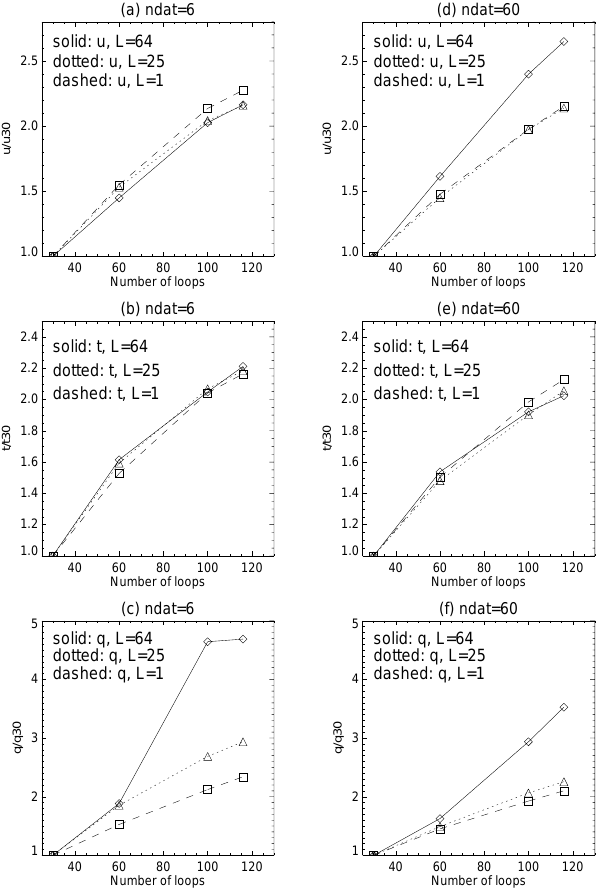
Fig. 6. The ratio of the mean OIS values using K = 30 , 60 , 100 , and 116 to the mean OIS value using K = 30 as a function of the number of loops at 1000hPa, 500hPa and 0.27hPa for: (a) u with ndat = 6, (b) t with ndat = 6, (c) q with ndat = 6, (d) u with ndat = 60, (e) t with ndat = 60, and (f) q with ndat =